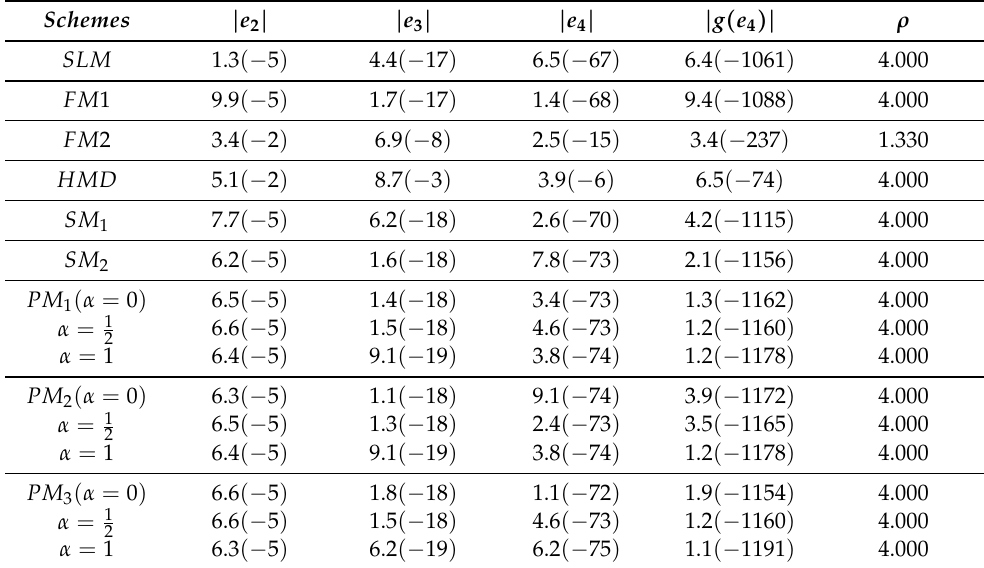
Table 3. Numerical results of Example 3.